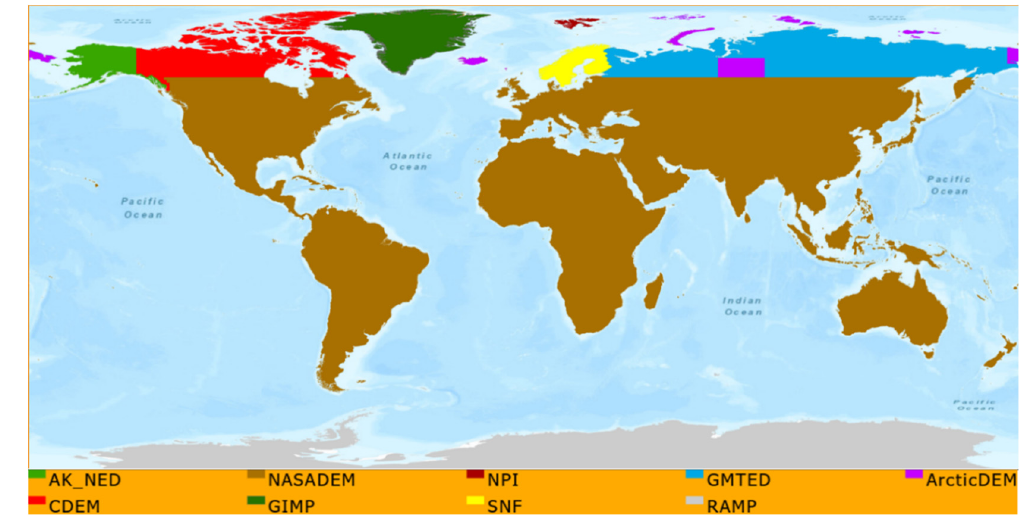
Figure 1. Landsat Collection-2 DEM data sources.